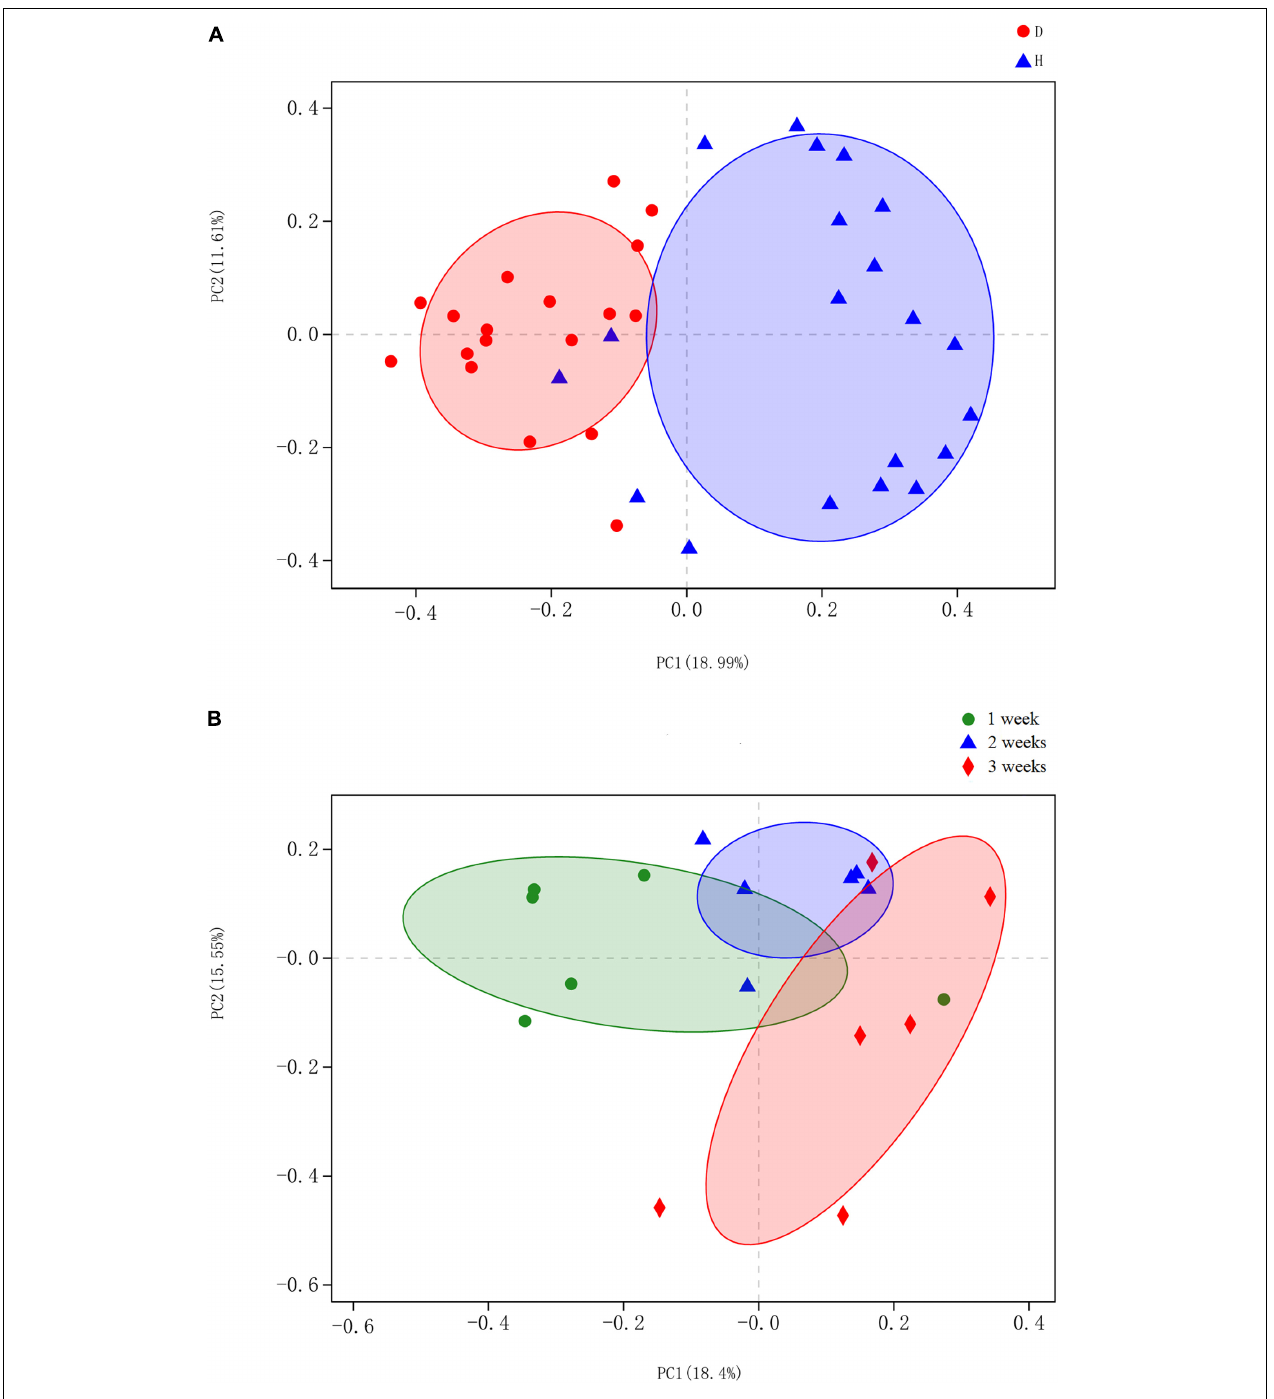
FIGURE 2 | Principal coordinates analysis (PCoA) was performed at the operational taxonomic unit (OTU) level based on unweighted UniFrac distance for all samples. Each group is represented in a different color and shape. (A) Scatterplot from PCoA showed a clear separation of diarrheal (D) from healthy (H) samples ( p < 0.05, analysis of similarity (ANOSIM)); Principal coordinates 1 and 2 (PC1 and PC2) represent 18.99 and 11.61% of the variance, respectively (x and y axes). (B) PCoA scatterplot identified significant bacteria compositional difference among the three ages ( p < 0.05, ANOSIM). Principal coordinates 1 and 2 (PC1 and PC2) represent 18.4 and 15.55% of the variance, respectively ( x and y